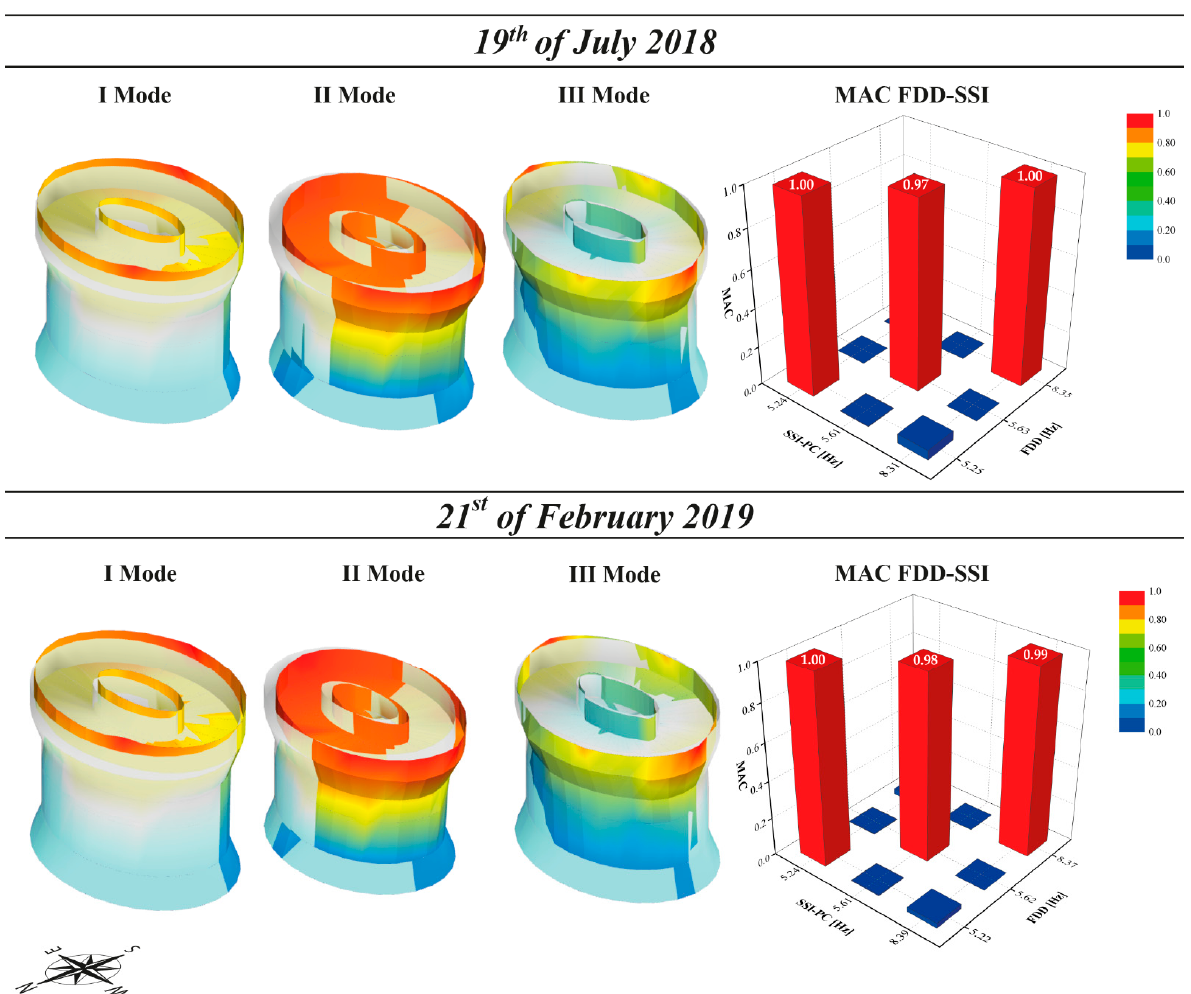
Figure 4. Cagli Tower’s modal shapes detected on 19 July 2018 and 21 February 2019 and comparison between FDD and SSI techniques with MAC -matrixes.